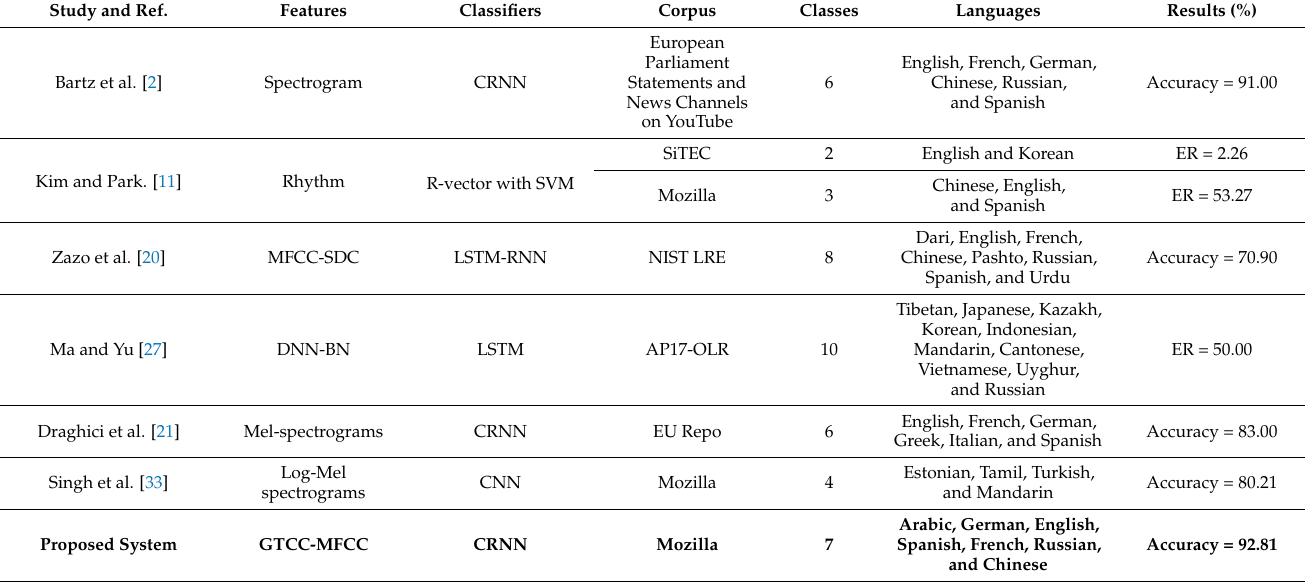
Table 9. Comparison of proposed CRNN language identification architecture with other studies using different corpora with varying numbers of